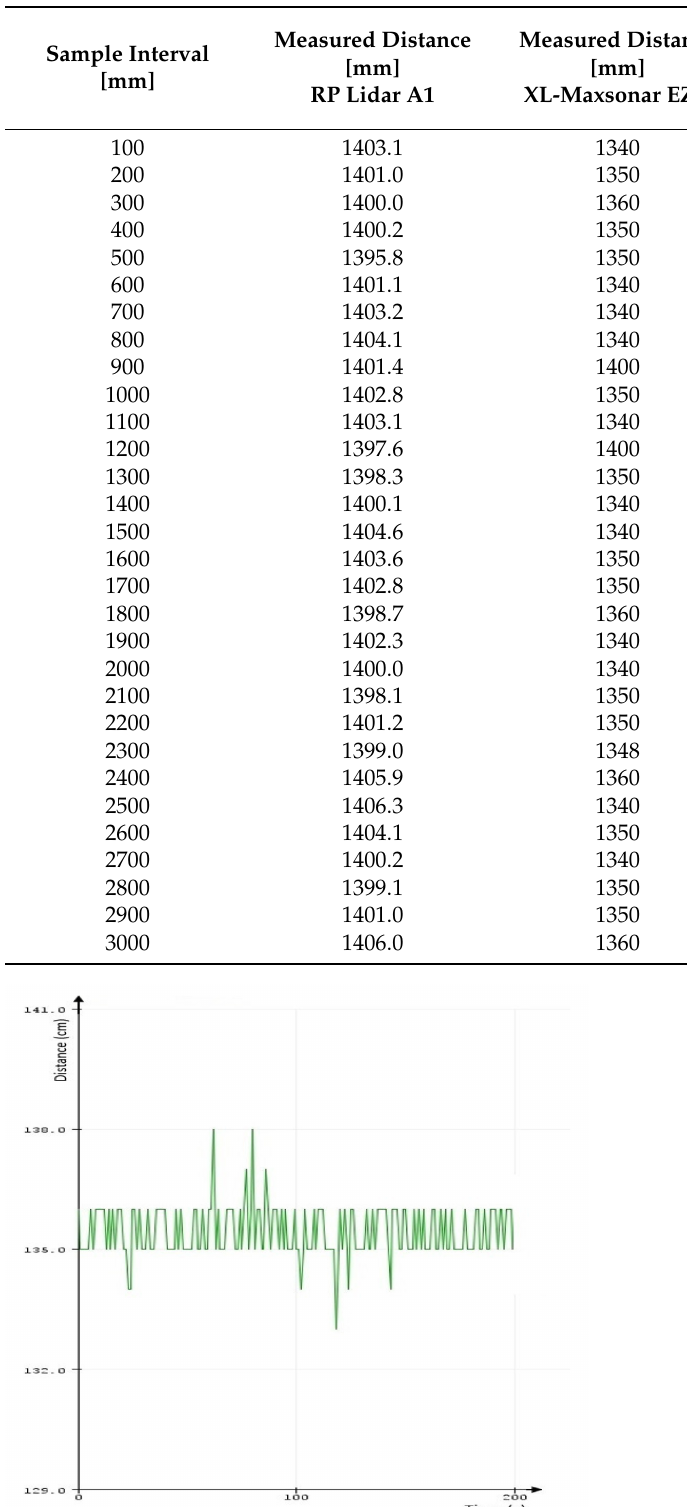
Figure 8. Direct data sampling from XL Maxsonar EX sensor